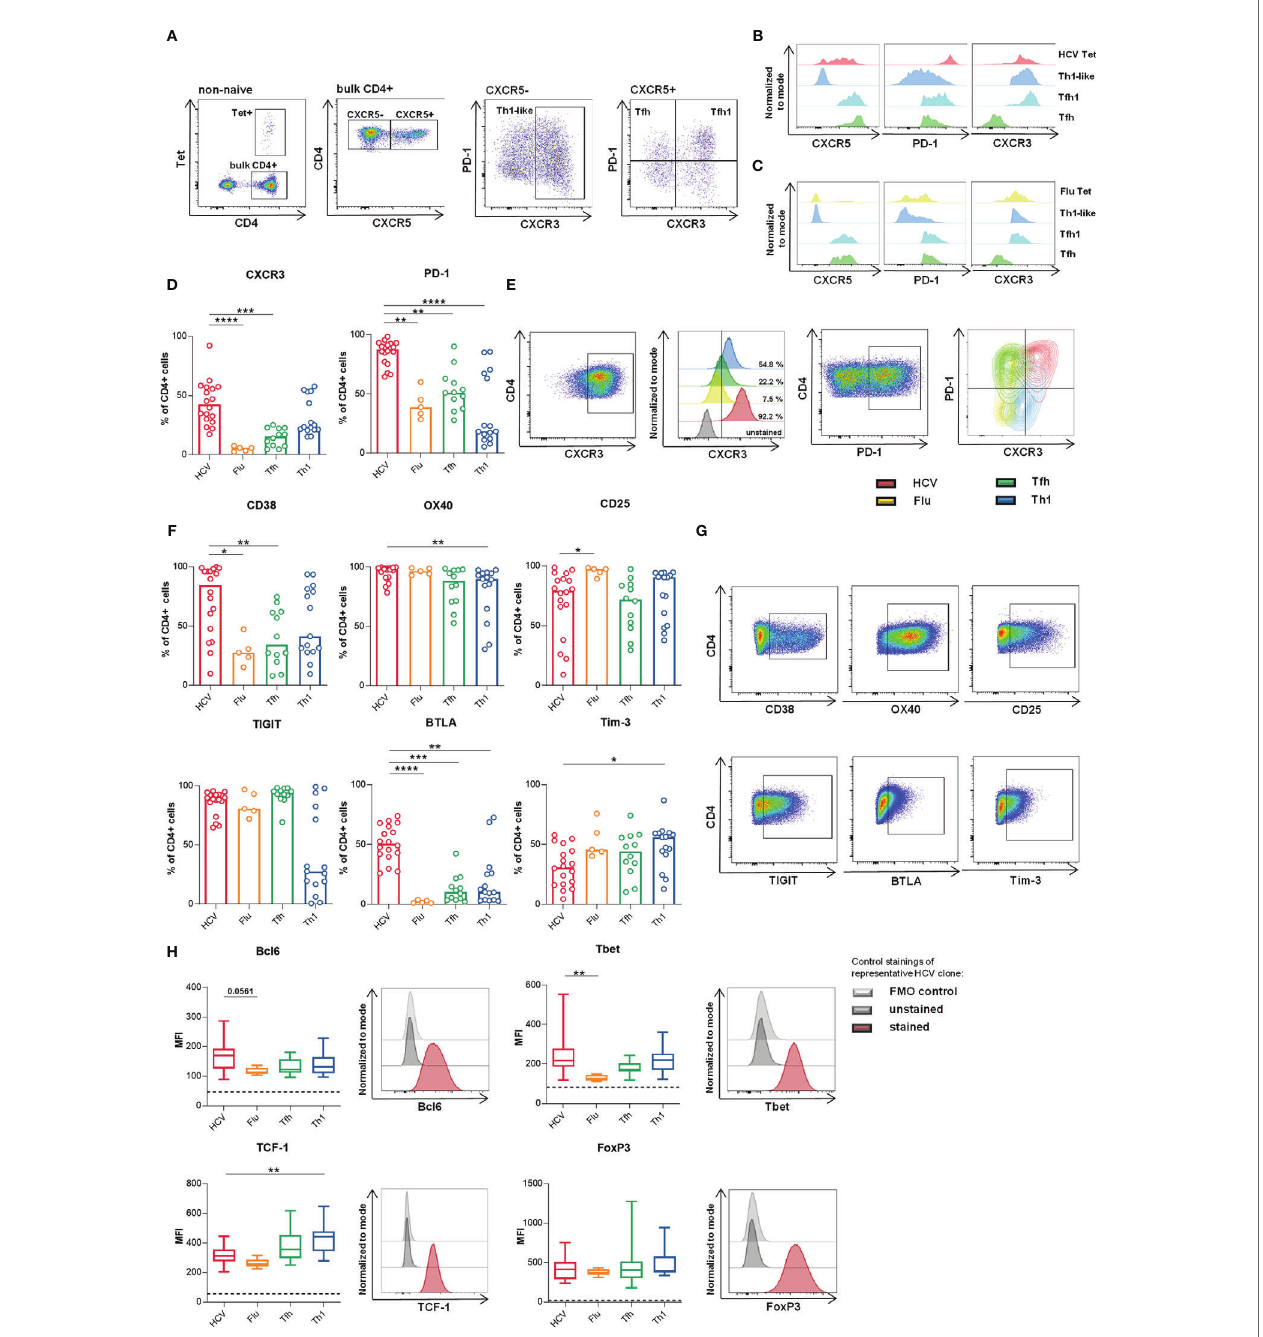
FIGURE 1 | HCV clones present phenotypic and transcriptional Th1-biased Tfh-like characteristics. (A – C) Representative dotplots and histograms of ex vivo analyzed HCV and Flu-speci fi c CD4 T cells in the peripheral blood (donor 2 and 17 respectively) after magnetic bead based tetramer enrichment as described previously (26, 35). (D – G) Surface marker expression on the clone types was analyzed by fl ow cytometry (n = 18 HCV, 5 Flu, 12 Tfh, 15 Th1 clones). (D) CXCR3 and PD-1 expression. (E) Stainings of data in (D) of representative clones as pseudocolor plots, histograms and overlaid contour plots, respectively. (F) Expression of activation and inhibitory markers among the clone types. (G) Representative stainings from data shown in (F) . (D, F) Bars represent the median. Each symbol represents one CD4 T cell clone of the indicated type. (H) Median expression (MFI) of relevant CD4 T cell lineage-associated transcription factors was analyzed by fl ow cytometry (n = 18 HCV, 5 Flu, 14 Tfh, 13 Th1 clones) and is shown as box plot with minimum to maximum whiskers. Dashed lines represent the MFI of unstained controls. A representative staining with unstained and fl uorescence minus one (FMO) control of one HCV clone is shown on the right side of each box plot. (D – H) Kruskal-Wallis test with Dunn ’ s test for multiple comparisons was applied to compare differences between all groups to HCV clones as control. *p < 0.05; **p < 0.01; ***p < 0.001; ****p <